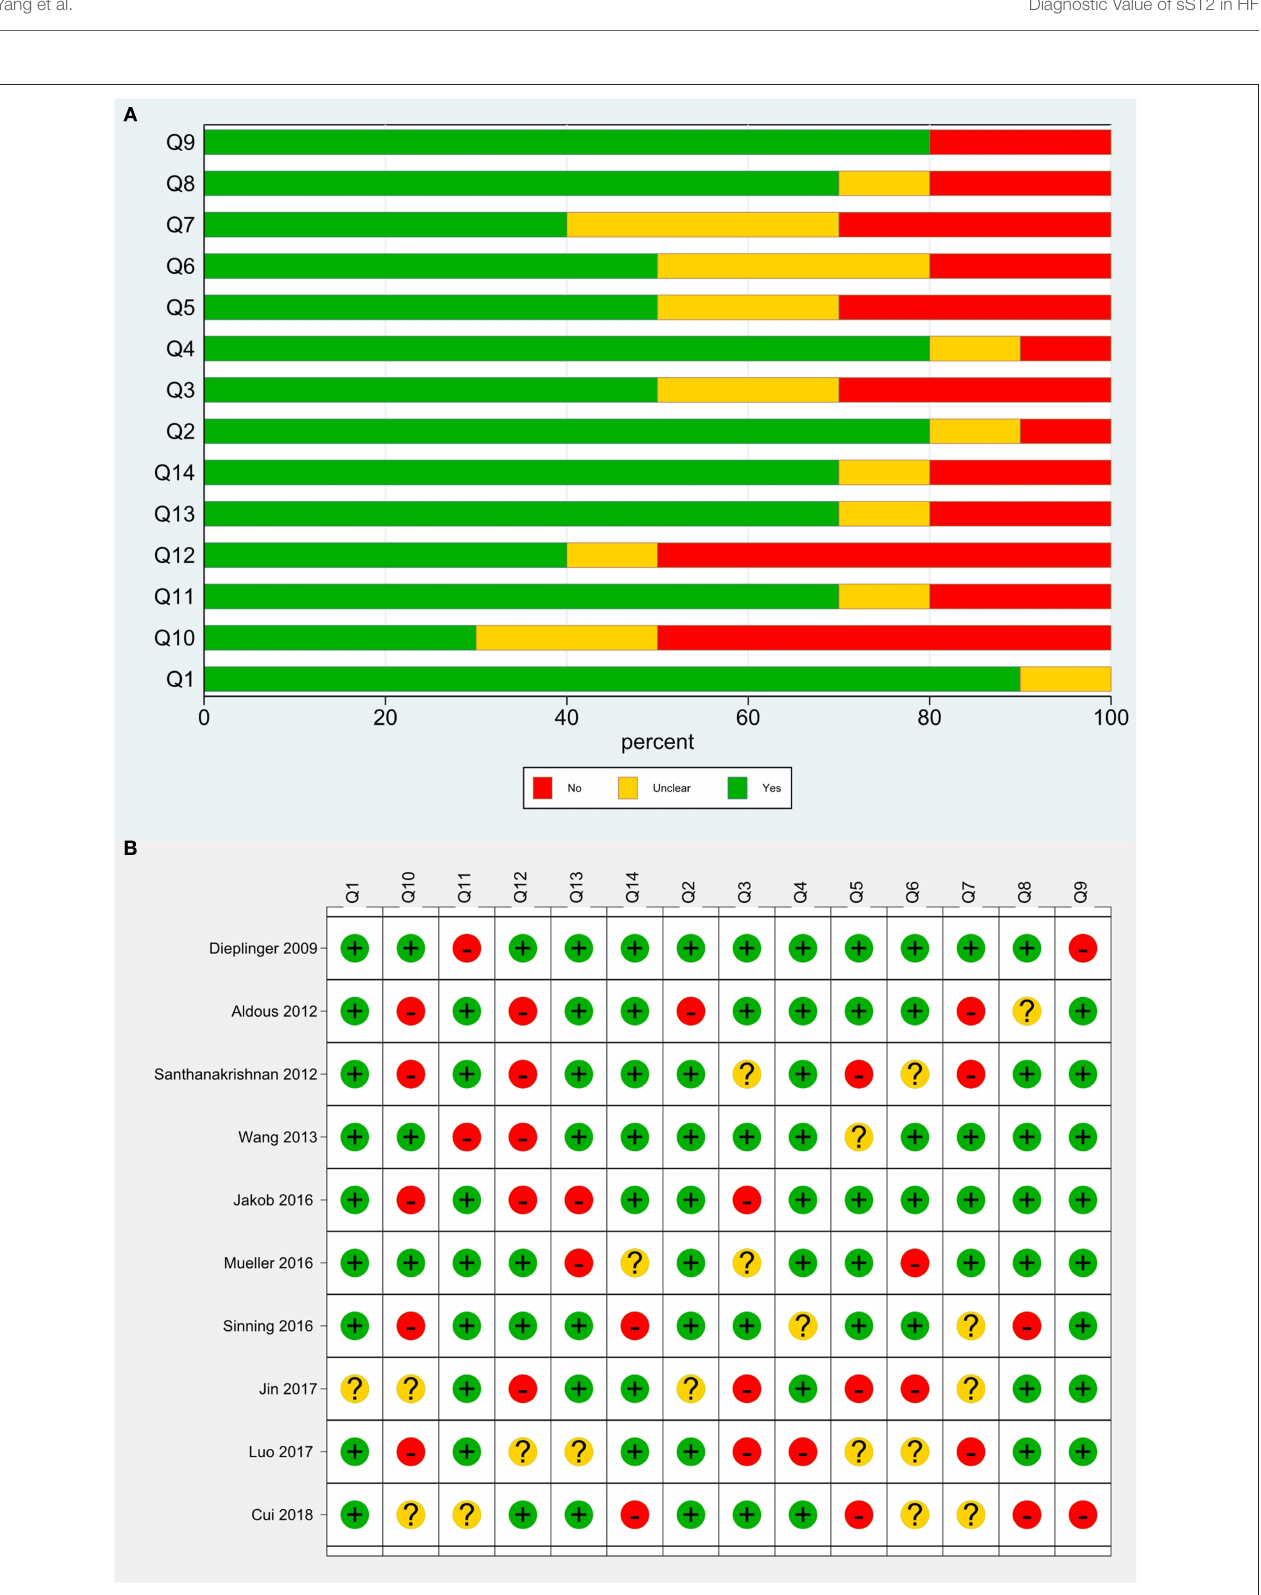
FIGURE 2 | Quality evaluation of the included studies. (A) Review authors’ judgments presented as percentages for the included studies; (B) Review authors’ judgements for each included study.